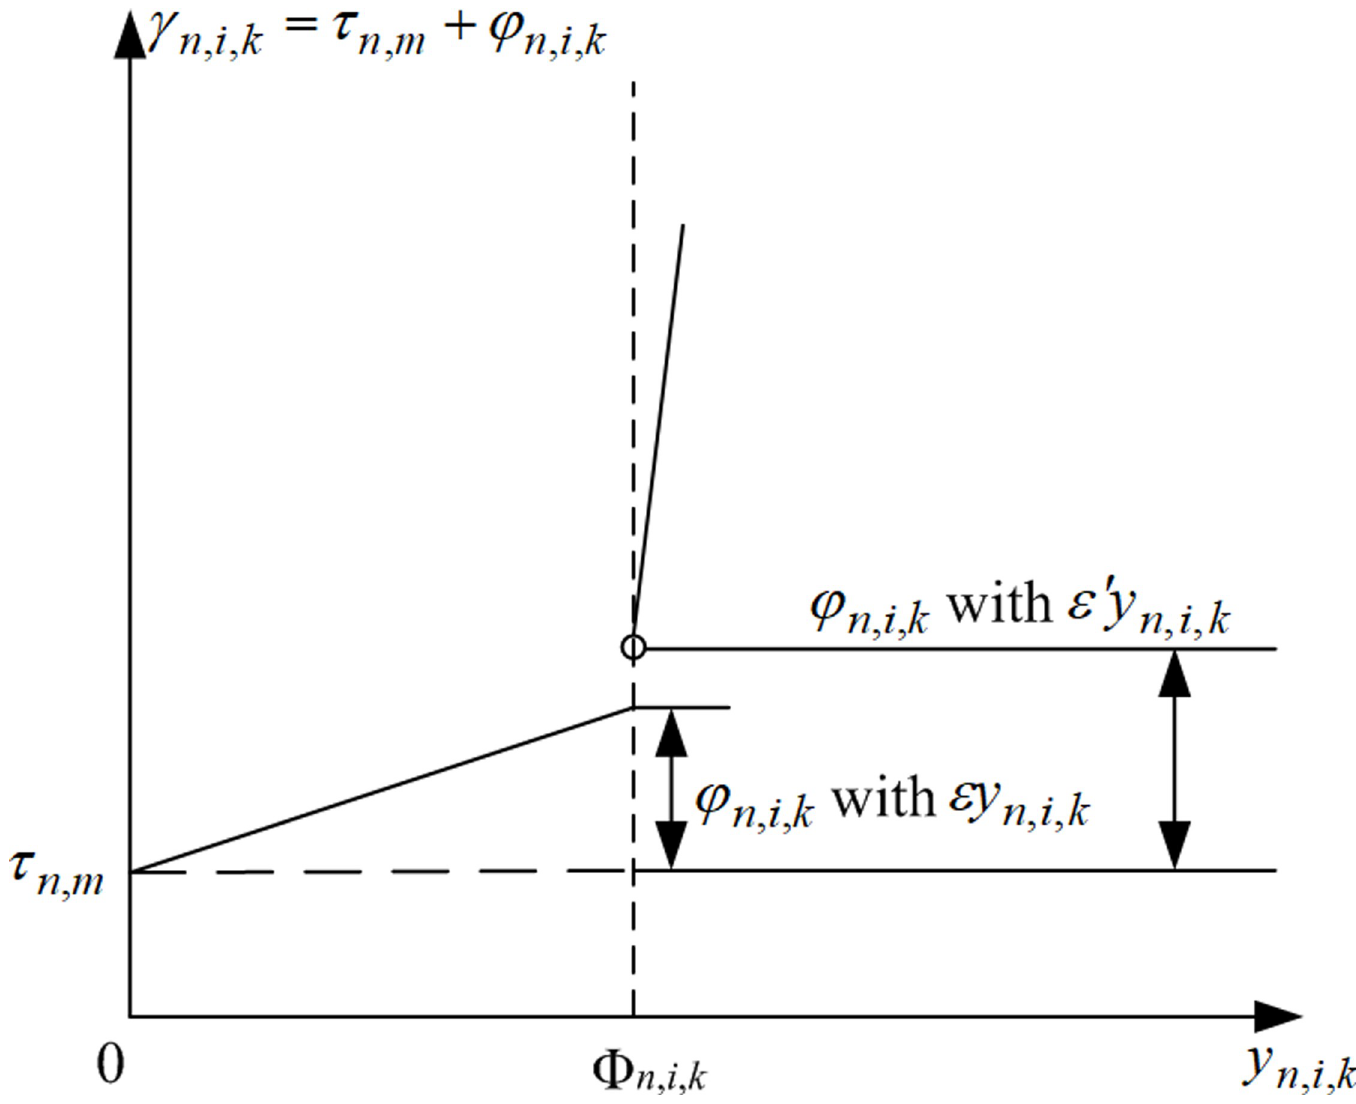
Fig 6. Proposed 2-piece linearized function for evaluating g